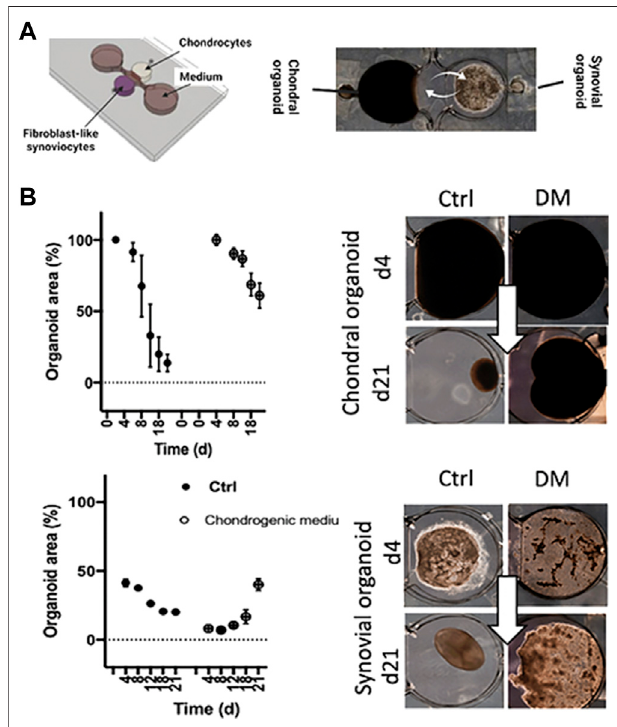
FIGURE 7 | Tissue level crosstalk fosters an anabolic and antiin fl ammatory joint environment. (A) A millimeter-sized 3D coculture model recapitulating only the soluble synovial and chondral tissue-crosstalk was used as an RA model based on healthy cadaveric chondrocytes and RA patient-derived FLS embedded in 3D hydrogels. (B) Analysis ofthe potentially fi brotic effect of commercial differentiation medium (DM) on condensation analysis of chondral and synovial cocultures. Adapted with permissions from (Rothbauer et al.,